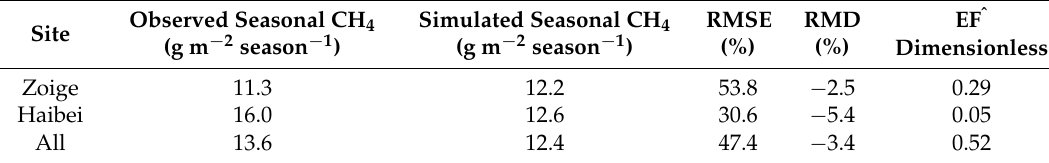
Table 2. Model performance on the study sites.